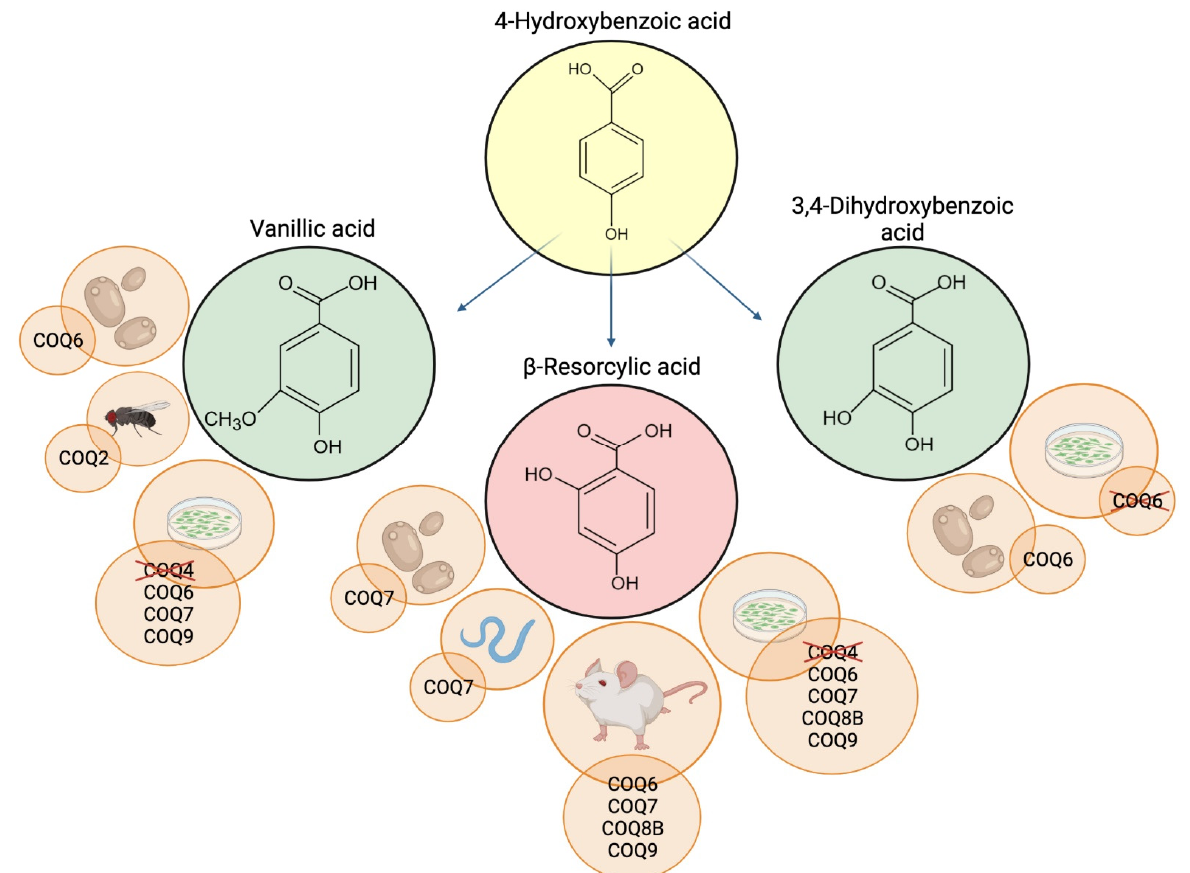
Figure 2. Schematic representation of 4-HB analogs and the CoQ-deficient models where they were tested. Deleted proteins indicate inefficacy of the supplementation. Created with BioRender.com (accessed on 25 March 2022).